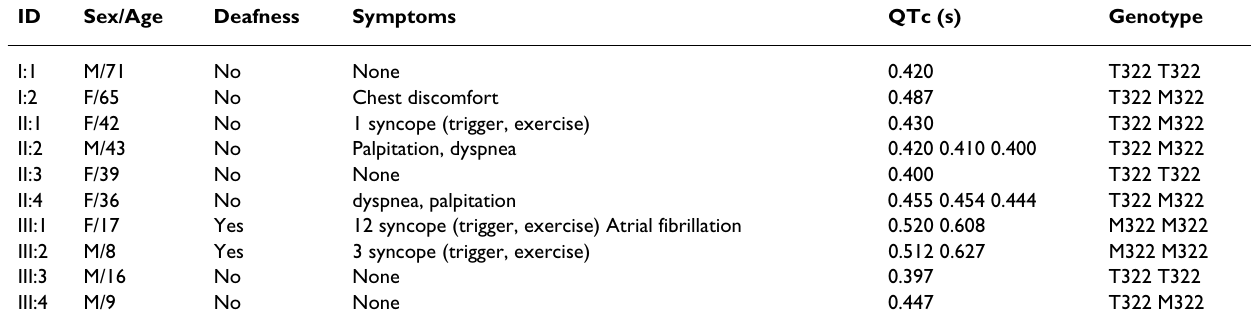
Table 1: Genotype-phenotype correlation in the Chinese family with both RWS and JLNS and KCNQ1 mutation